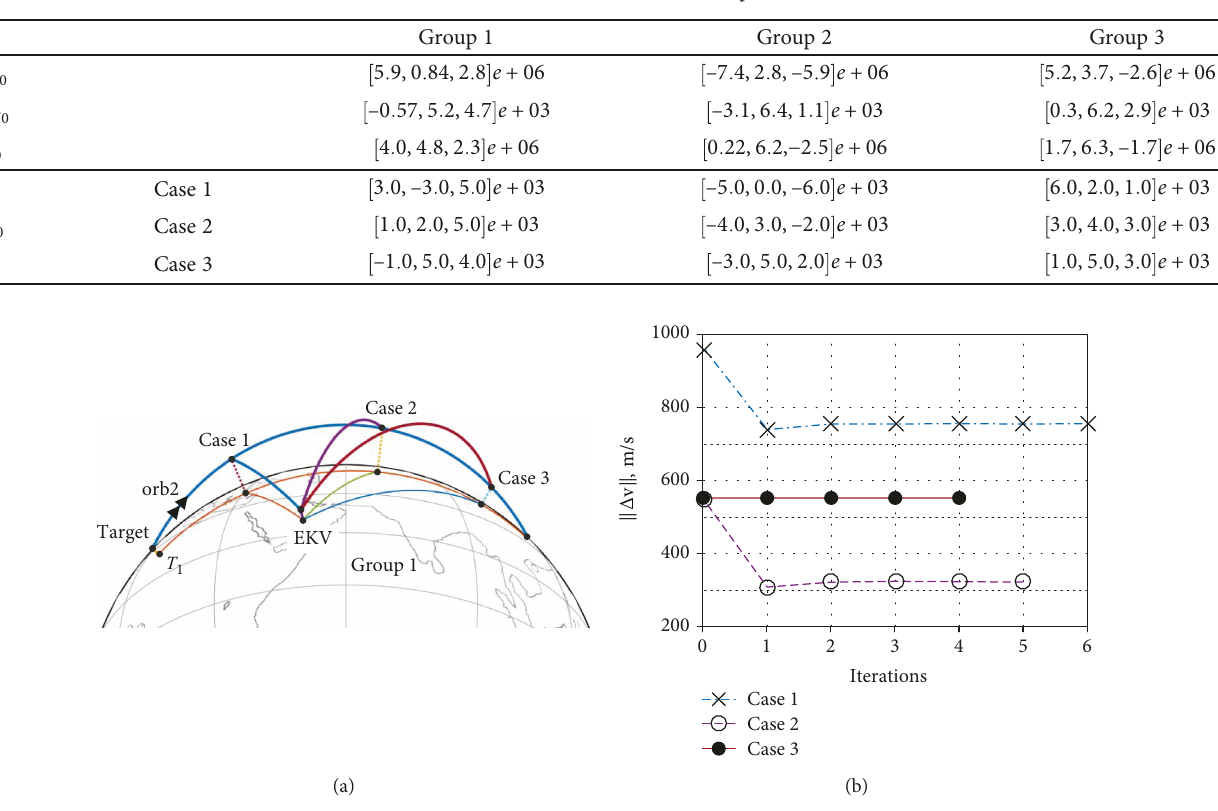
Figure 3: The engagement geometry (a) and the iterative process (b) of Group 1.